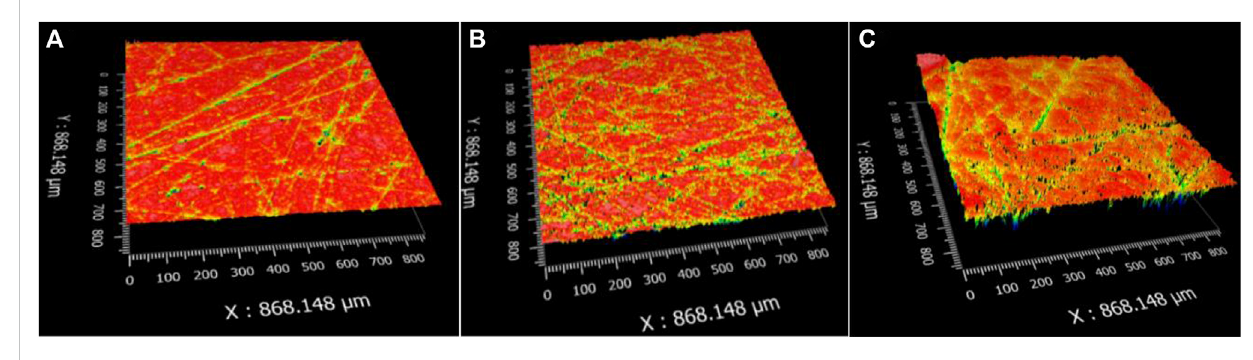
FIGURE 3 Surface morphology with the abrasive particle size of (A) 5 μ m, (B) 15 μ m, and (C) 20 μ